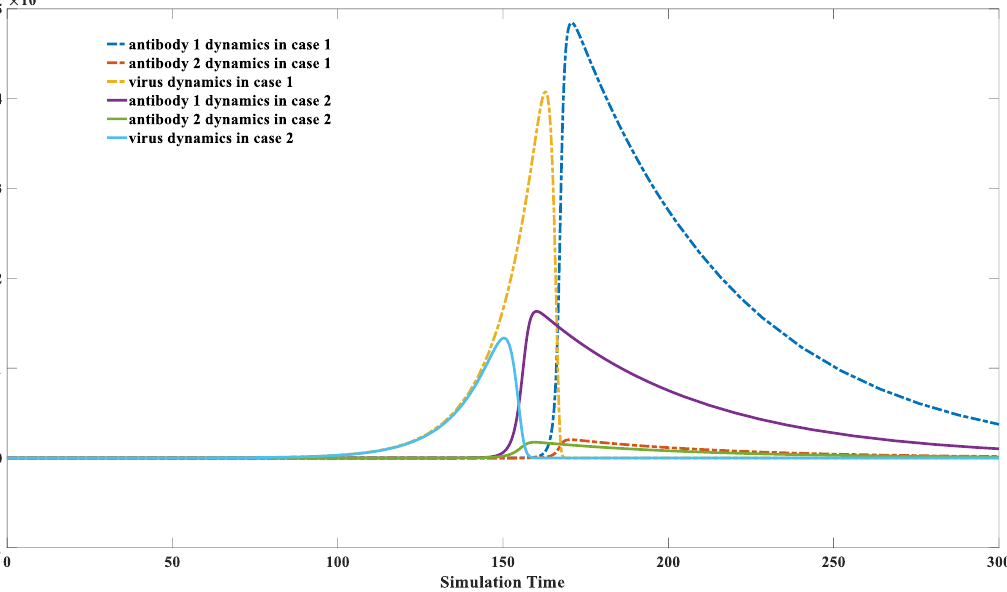
Figure 7. High concentrations of weakly binding antibodies can provide effective protection. A plot of the inhibitory capacity of a specific concentration of weakly binding antibodies against infection is presented. Two types of antibodies are presented in this figure: antibody 1 has a strong binding capacity ( K 1 on = 1 × 10 − 5 ) while antibody 2 has a relatively weak binding capacity ( K 2 on = 5 × 10 − 6 ). Two scenarios are simulated: both antibodies have low initial concentrations in case 1; weakly binding antibody has a high initial level in case 2. The parameter sets we used are: x 1 (0) = x 2 (0) = 0, y 1 (0) = y 2 (0) = 1, z (0) = 1, w 1 = w 2 = 1, K 1 on = 1 × 10 − 5 , K 1 off = 1 × 10 − 14 , K 2 on = 5 × 10 − 6 , K 2 off = 1 × 10 − 14 , k 3 = 1, k 4 = 2, k 5 = k 6 = 0.02, k 1 = 0.1 for case 1; y 2 (0) = 100 for case 2. It can be